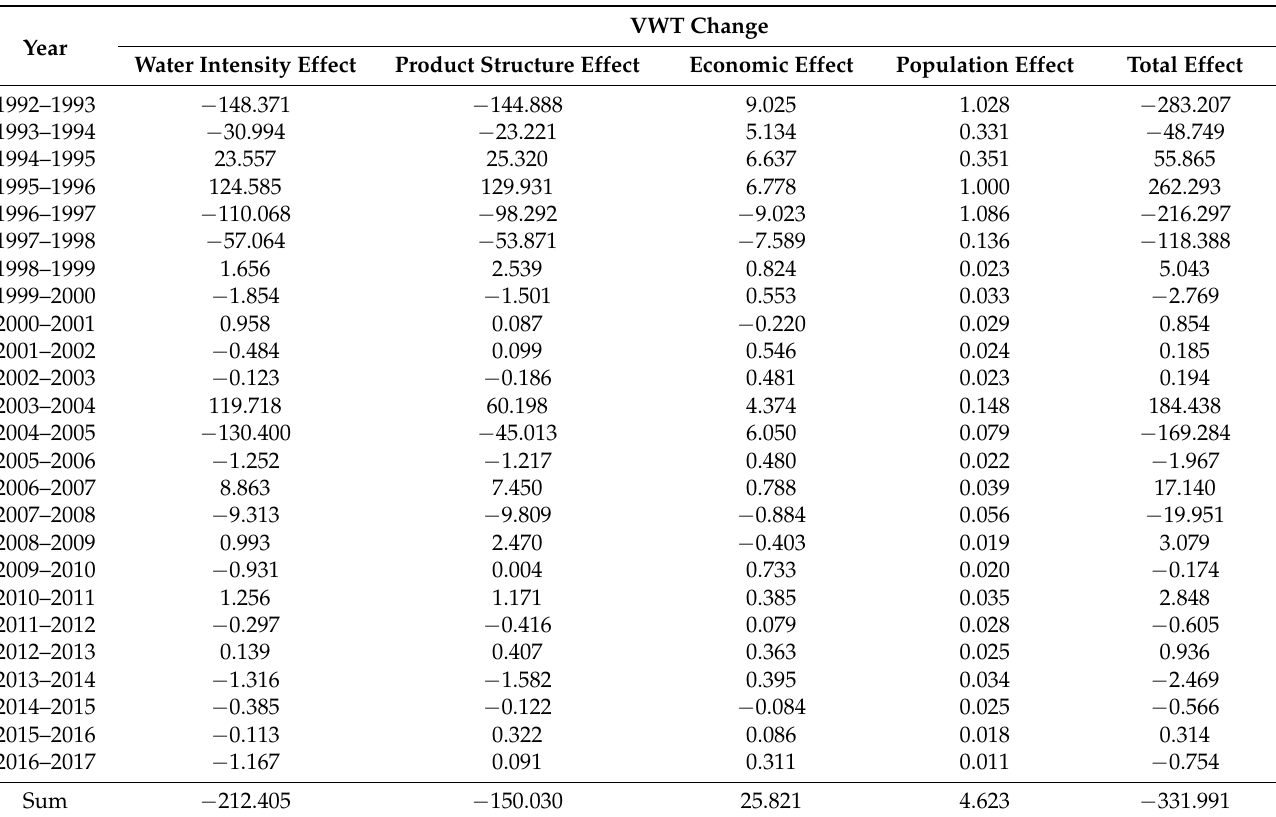
Table A7. The logarithmic mean divisia index (LMDI) analysis of sorghum virtual water trade (VWT) change in South Korea (million m 3